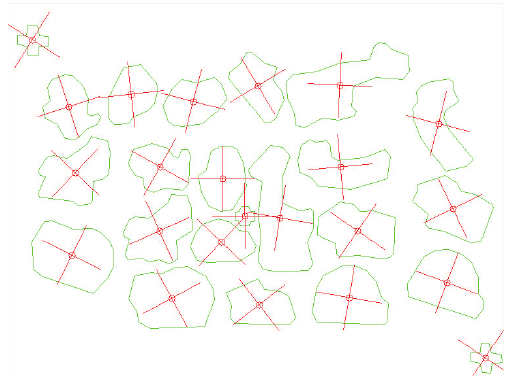
Figure 22: Extracted and approximated contours of the puzzle